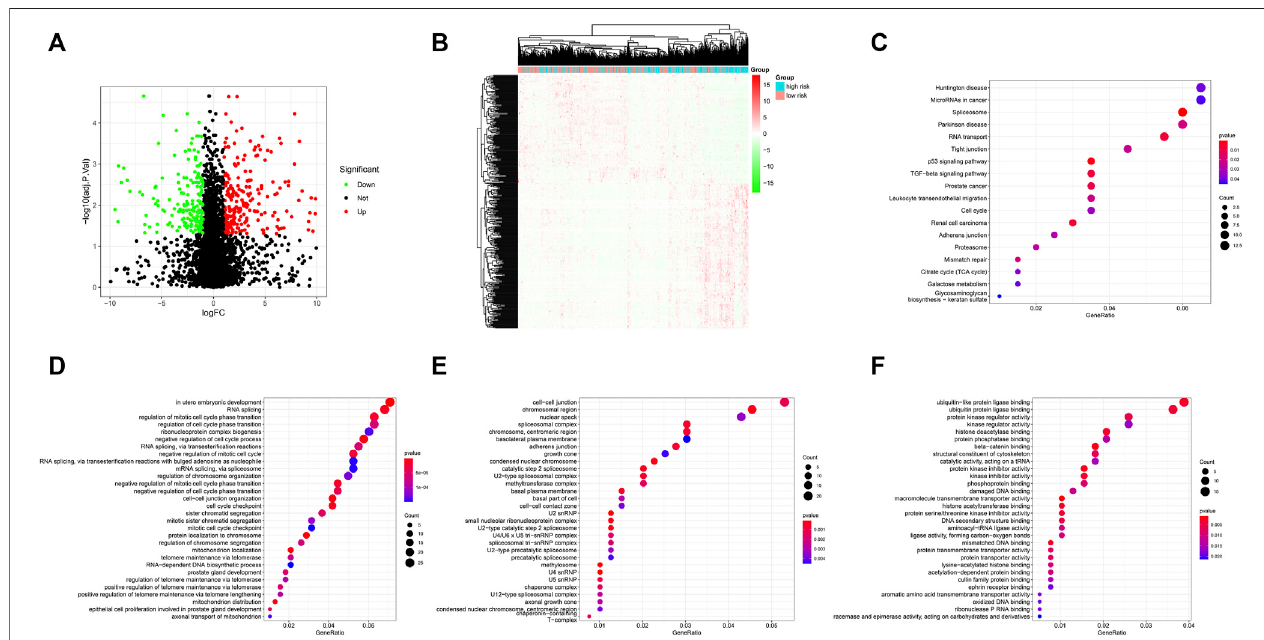
FIGURE 6 | (A) Volcano plot of differentially expressed genes (DEGs); (B) Heatmap of the DEGs; (C – F) GO and KEGG enrichment analysis for DEGs. KEGG pathway (C) , BP (D) , CC (E) , and MF (F)